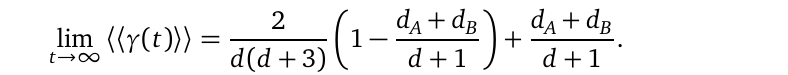
Figure 11: Numerical average purity: a qubit-qubit system for growing samples of GUE-Hamiltonians. In black the ana- lytic 〈〈 γ ( t ) 〉〉 .